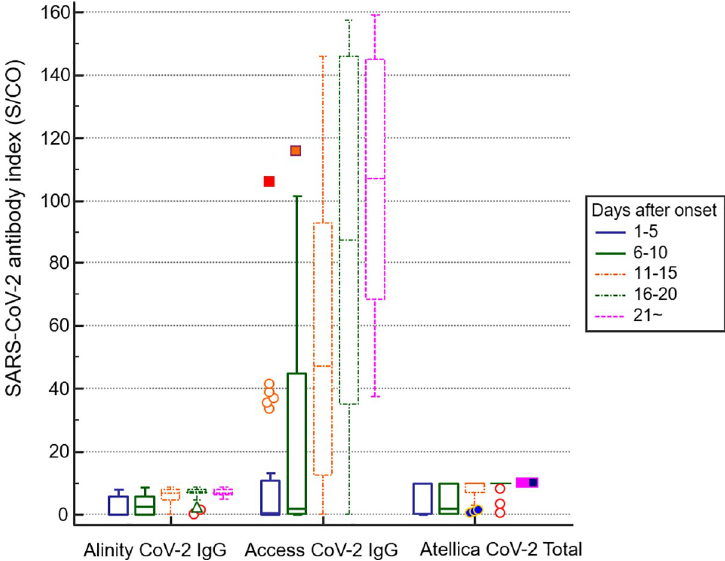
Fig 1. Distribution of the SARS-CoV-2 antibody S/CO index measured by three chemiluminescence immunoassays according to days after onset.